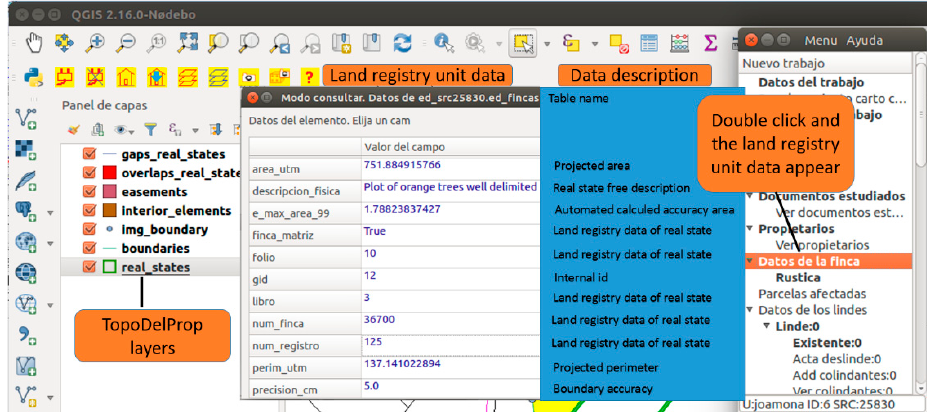
Figure 7. Data inquiry with TopoDelProp plug ‐ in showing the parcel data. Source: own elaboration.